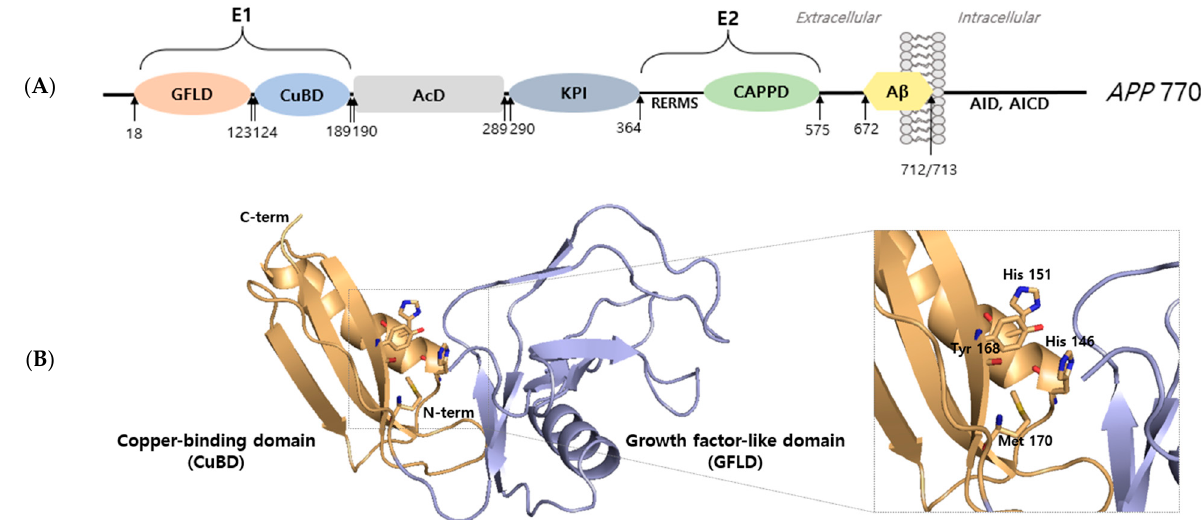
Figure 1. Structural analysis of amyloid precursor protein. ( A ) Schematic representation of the full-length APP 770 isoform domain. Amyloid precursor protein consists of an extracellular 1 (E1) region containing a growth factor-like domain (GFLD) and a copper-binding domain (CuBD). The E1 region is followed by an acidic domain (AcD) and Kunitz protease inhibitor (KPI) domain. The extracellular 2 (E2) region contains the RERMS sequence and the central APP domain (CAPPD). E2 is a linked linker. The region between the linker and transmembrane (TM) constitutes amyloid beta (A β ). The intracellular region of APP is called APP intracellular domain (AID, AICD). ( B ) X-ray structure (PDB ID: 4PWQ) of the E1 region of APP showing the growth factor-like domain (GFLD) and the copper-binding domain (CuBD). The stick represents the copper binding